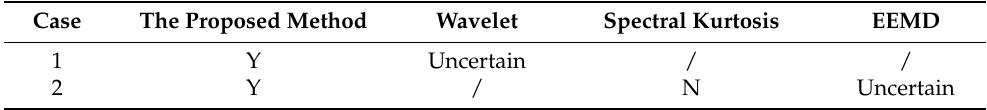
Table 4. Fault identification outcomes using 4 methods.